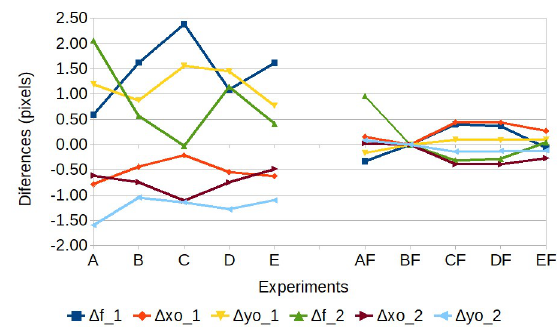
Figure 6. Differences in the estimated IOPs (focal lengths and coordinates of principal points) of two bands with reference to experiment